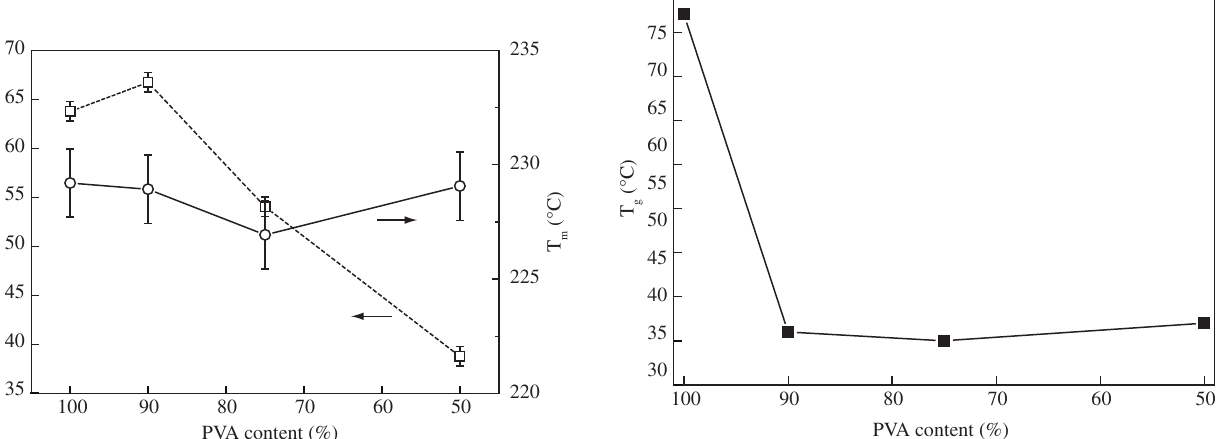
Figure 6. PVA glass transition temperature as a function of PES